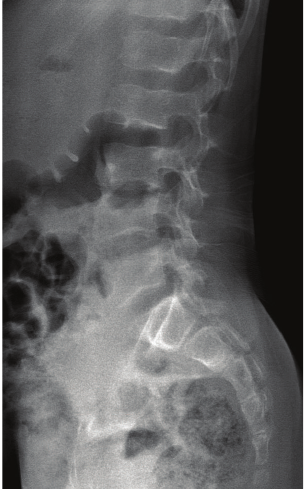
Figure 5: Lateral radiograph of the lumbar spine 2 months after the surgery shows complete collapse of the L3-L4 disk space with marked sclerosis, irregularities, and erosion of the inferior endplate of L3 and superior endplate of